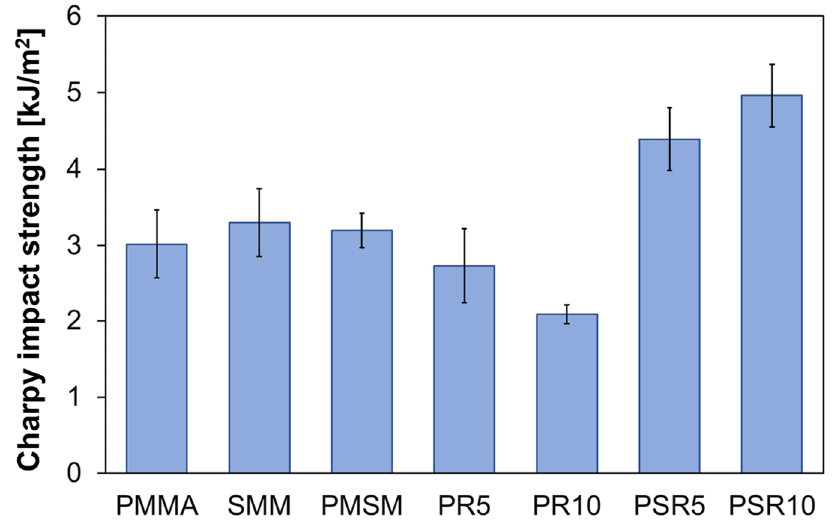
Figure 7. Notched Charpy impact test results for the matrix resins, PMMA/PR blends, and PMMA/SMM/PR